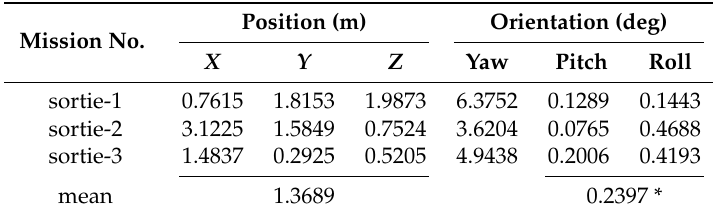
Table 2. Standard Deviation Statistics Summary of the POS